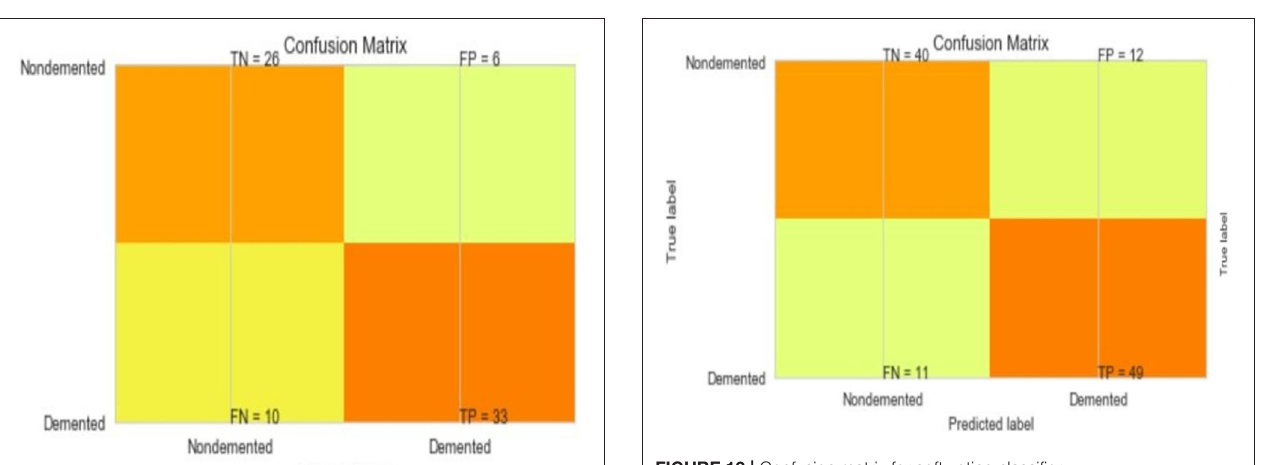
FIGURE 12 | Confusion matrix for soft voting classifier.